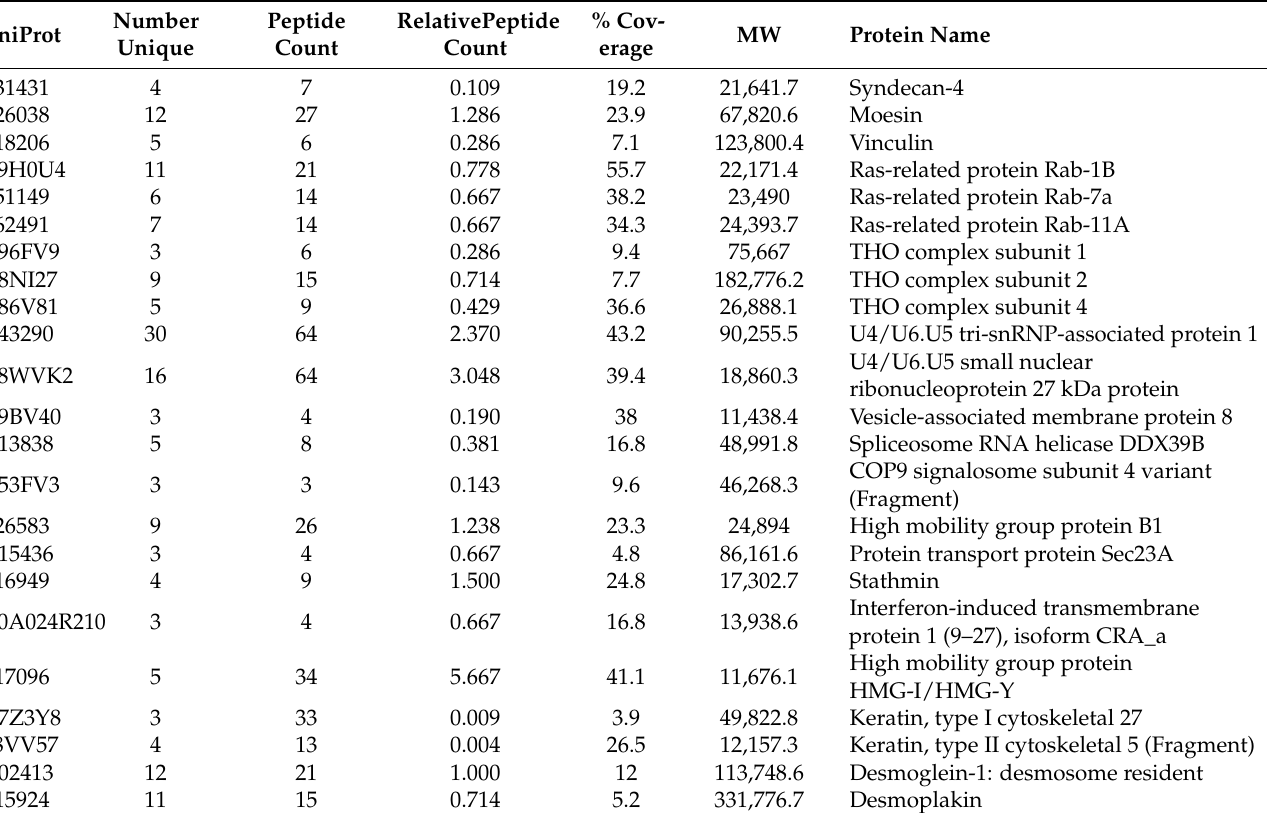
Table 1. The AAV9 interactome in SDC4